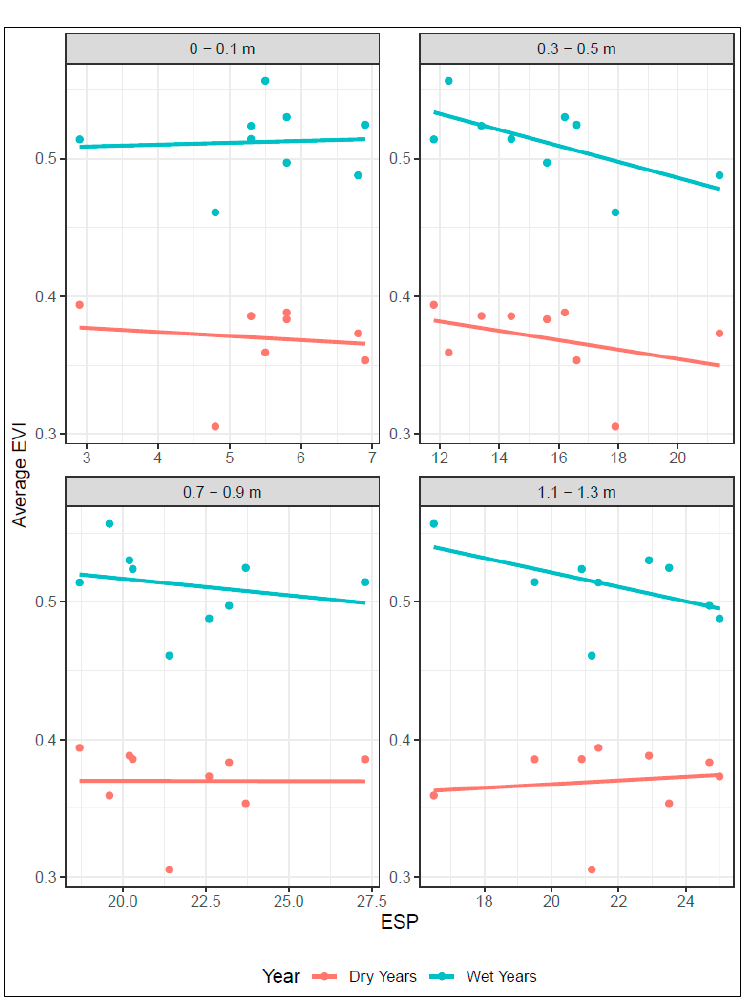
Figure A1. The relationship between average EVI (climate years were grouped by pre-defined ICR thresholds) and soil ESP for four soil depths at Field 1 for dry and wet years.